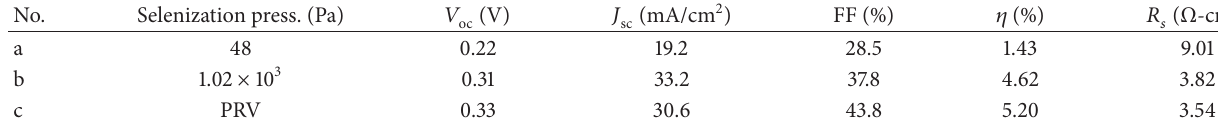
Table 2: Photovoltaic performance of CIGS solar cells with various selenization pressures.